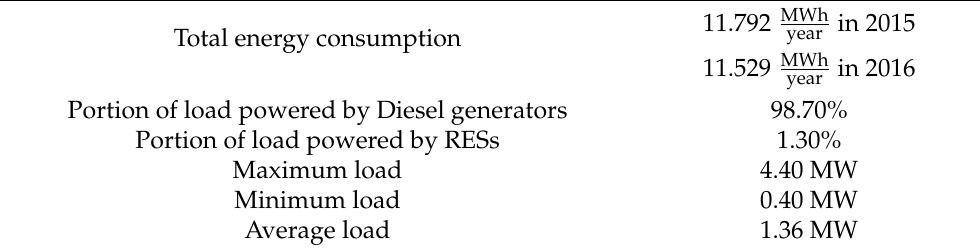
Table 1. Electric load data of the island of Ponza.